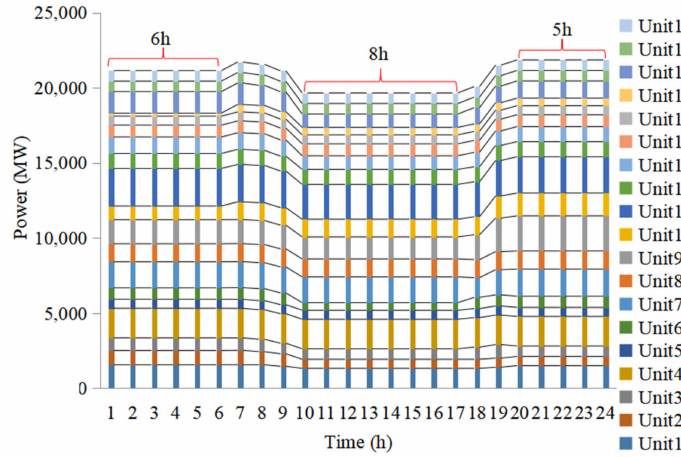
Figure 11. The power outputs of thermal generators in Case 2.